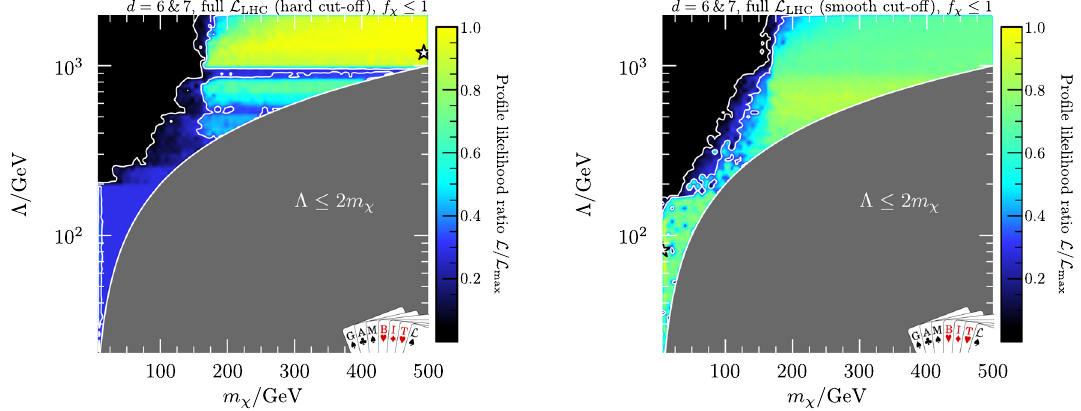
Fig. 11 Profile likelihood in the m χ – (cid:2) parameter plane when con- sidering dimension-6 and dimension-7 operators and including the full LHC likelihood. In the left (right) panel, we impose a hard (smooth)